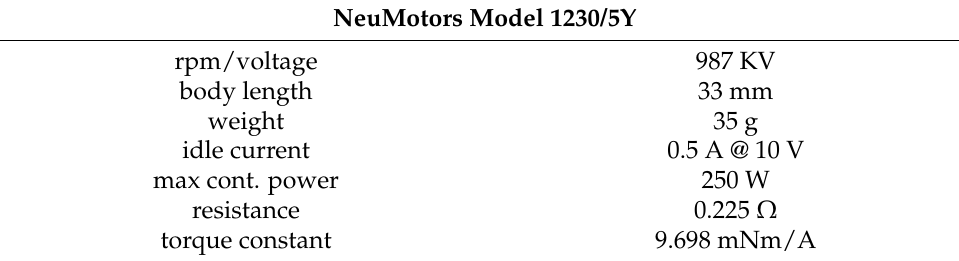
Table 3. Design of a modular drone: datasheet of the NeuMotors model